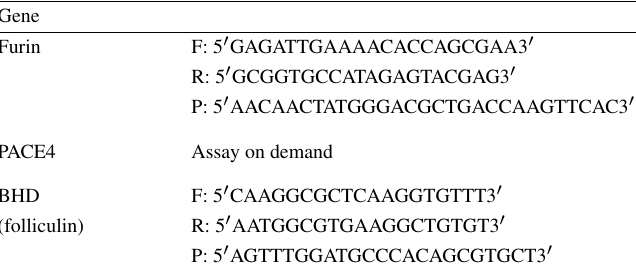
Primers used to amplify the human furin and PACE-4 by real-time PCR and the expected size of the